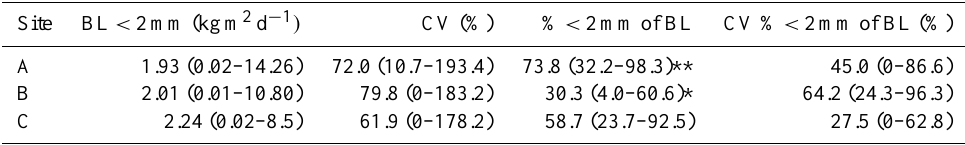
Table 7. Mean and range of daily bedload (BL) < 2mm, of the percentage of BL < 2mm of the total BL and of the coefficient of variation (CV) of the weekly values within the six samplers at the three